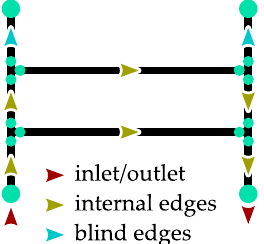
Figure 4. Internal flows in a system vs. flow mixing; there are 4 locations (the T-joints) for which the flow mixing/splitting equations must be present in the final linear system.